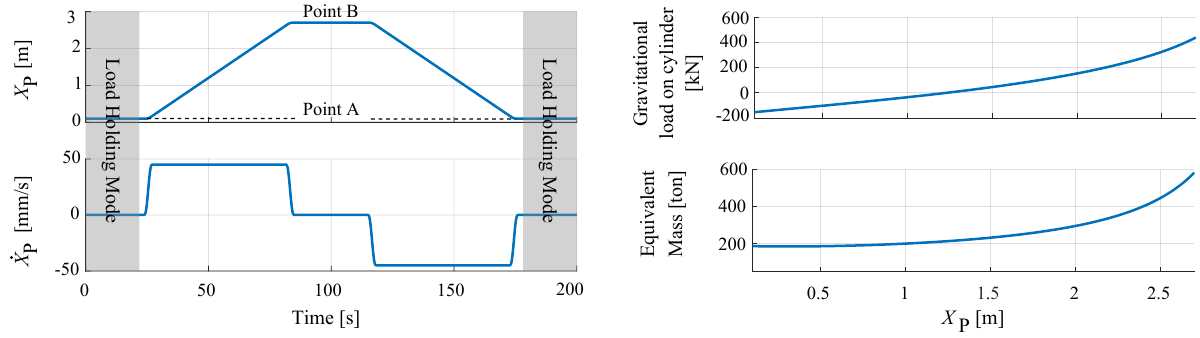
Figure 4: Considered motion trajectory in actuator space.